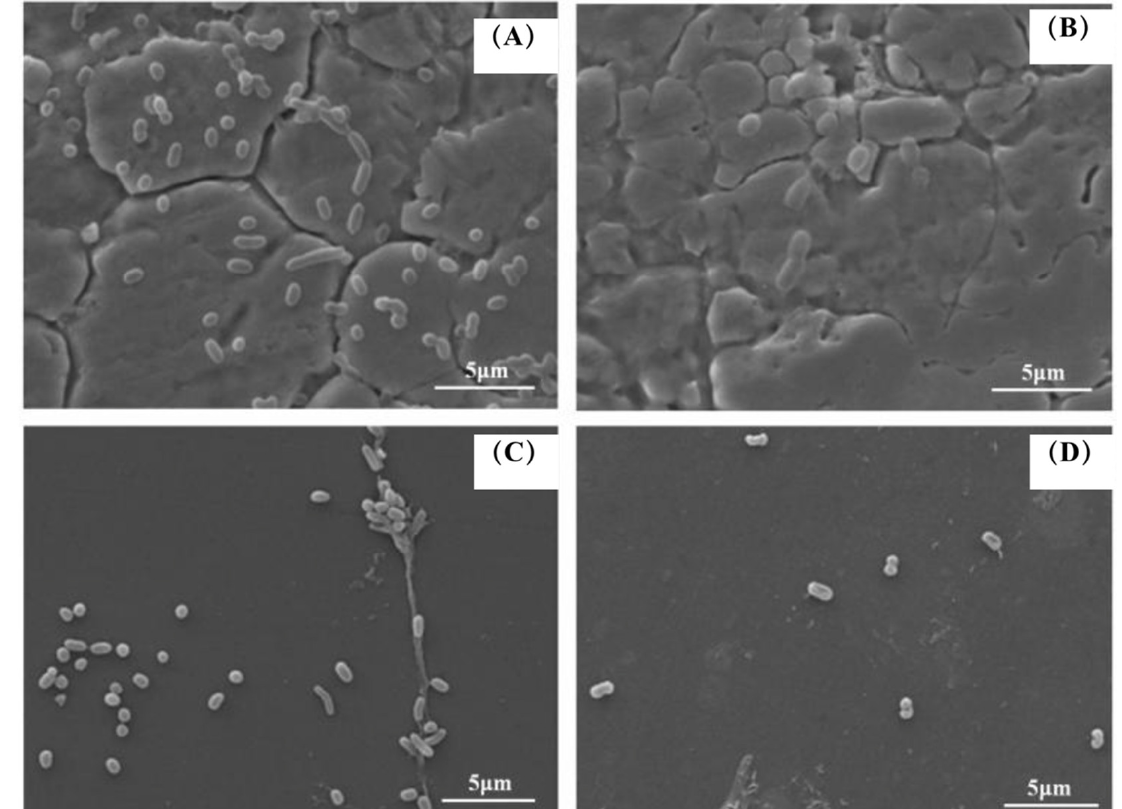
Figure 7. Effect of combined enzymes on the structure of biofilm on different carriers (representative images): ( A ) control group on nonrust steel; ( B ) combined enzymes on nonrust steel; ( C ) control group on glass; ( D ) combined enzymes on glass.